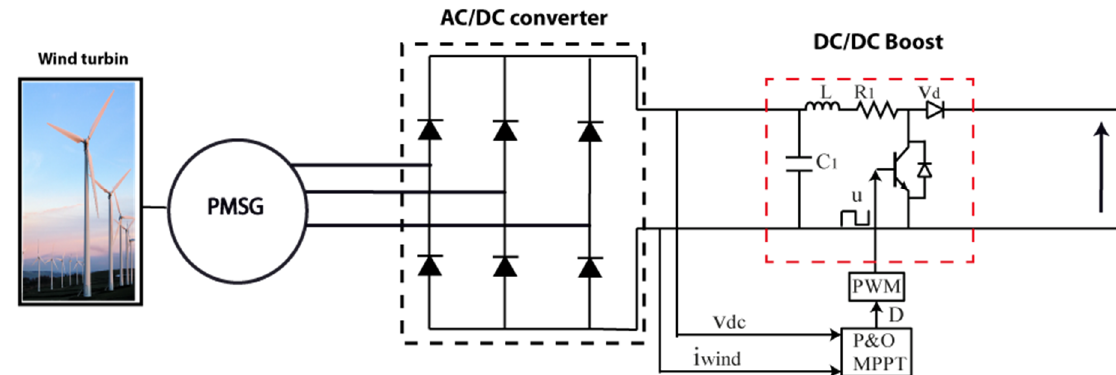
Figure 6. Wind turbine system.